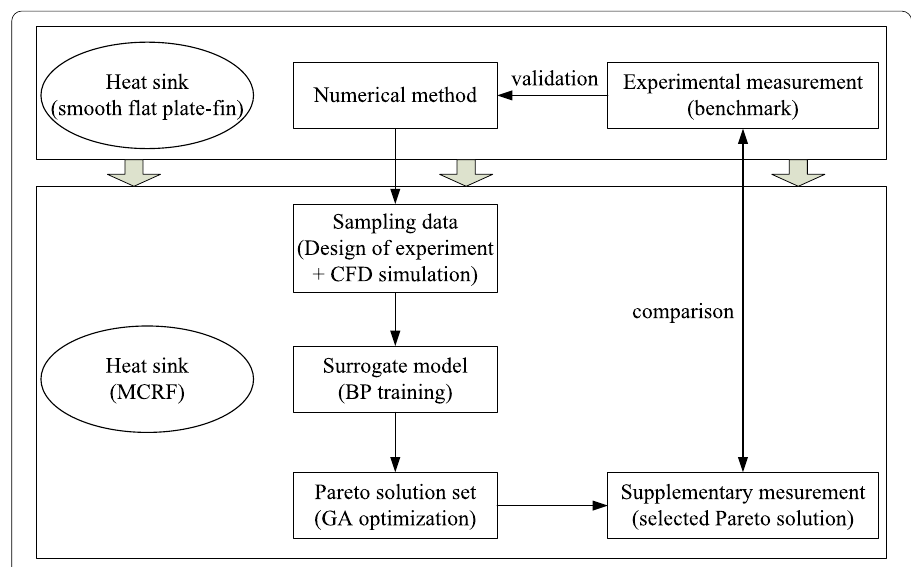
Fig. 1 The general methodology flow